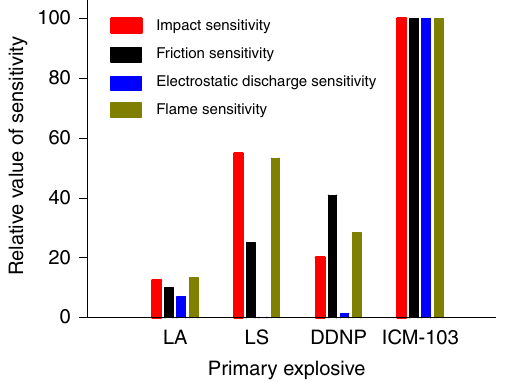
Fig. 3 The comparison of sensitivities of several typical primary explosives and ICM-103. Comparison of impact, friction, electrostatic discharge, and fl ame sensitivities for LA, LS, DDNP,